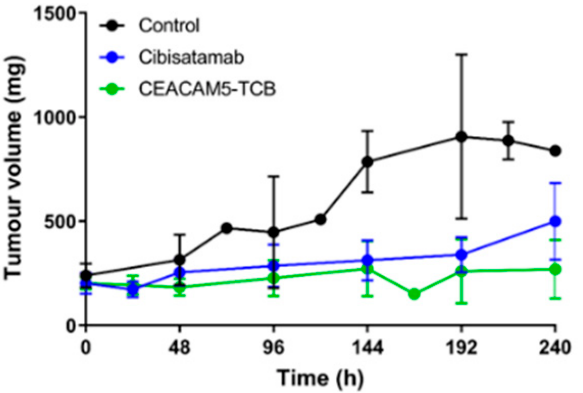
Figure 5. Tumour growth inhibition after single dose of TCB: Tumour volumes were reported by calliper measurements. Untreated tumour growth is shown for the vehicle group (black, n = 9) and tumour growth inhibition over 10 days after i.v. administration of 2.5 mg/kg of TCBs for cibisatamab (blue, n = 18) and CEACAM5-TCB (green, n = 17). Data are represented as mean ± SD. Cibisatamab